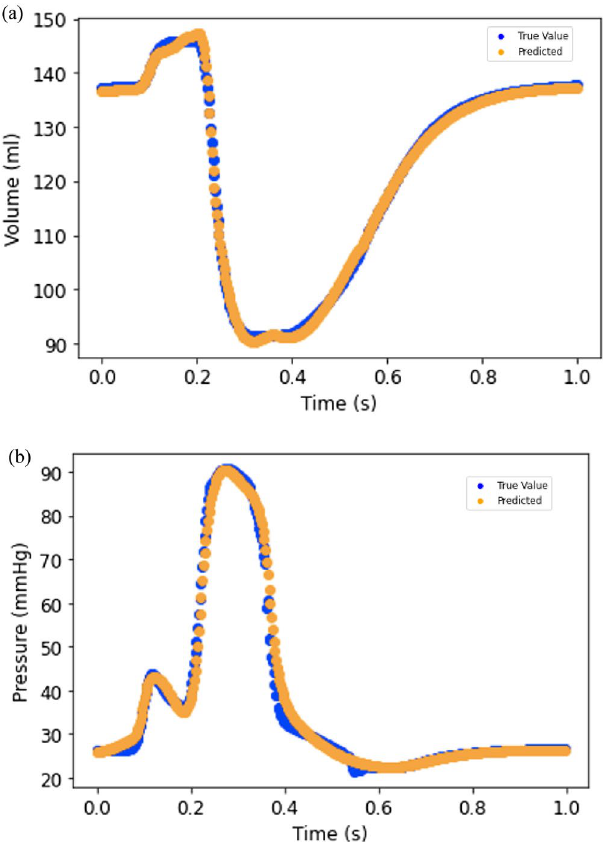
Figure 3. ( a ) LV volume from FE (blue) and feed forward DL (orange); ( b ) LV pressure from FE (blue) and feed forward DL